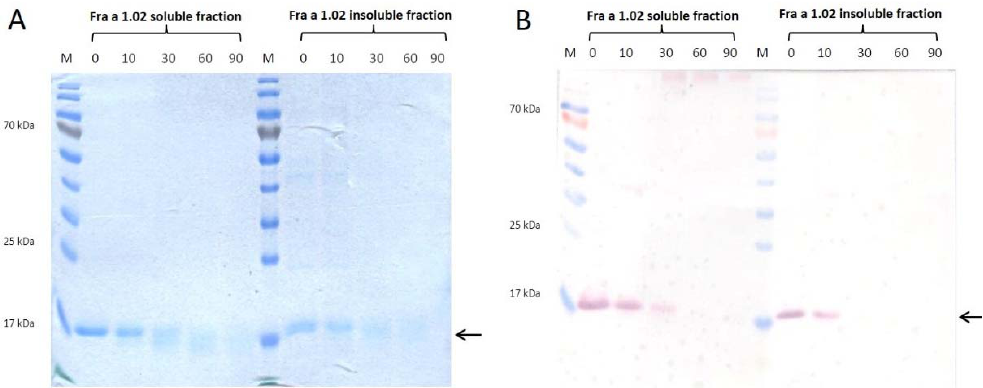
Figure 1. Heat stability of recombinant Fra a 1.02. ( A ) SDS-PAGE performed under reducing conditions with β -mercaptoethanol and ( B ) Western blot analysis of dialyzed elution fractions of the rFra a 1.02 protein purified from soluble and refolded insoluble fraction. Two µg of protein were heated for 10, 30, 60 and 90 min at 99 °C. Untreated protein served as control (0). Coomassie Brilliant Blue G250 was used for protein staining. For Western blot specific polyclonal anti-Fra a 1.02 antibody was used. M: PageRuler Prestained Protein Ladder.